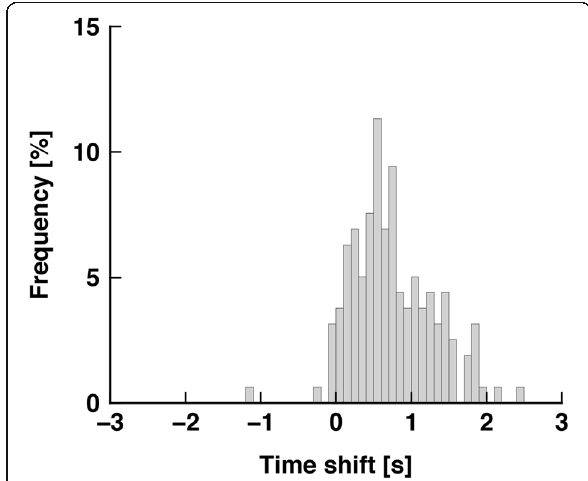
Fig. 4 Histogram of the time shift for source parameters used in the present study. The positive and negative values indicate positive and negative delay times from each origin time, respectively